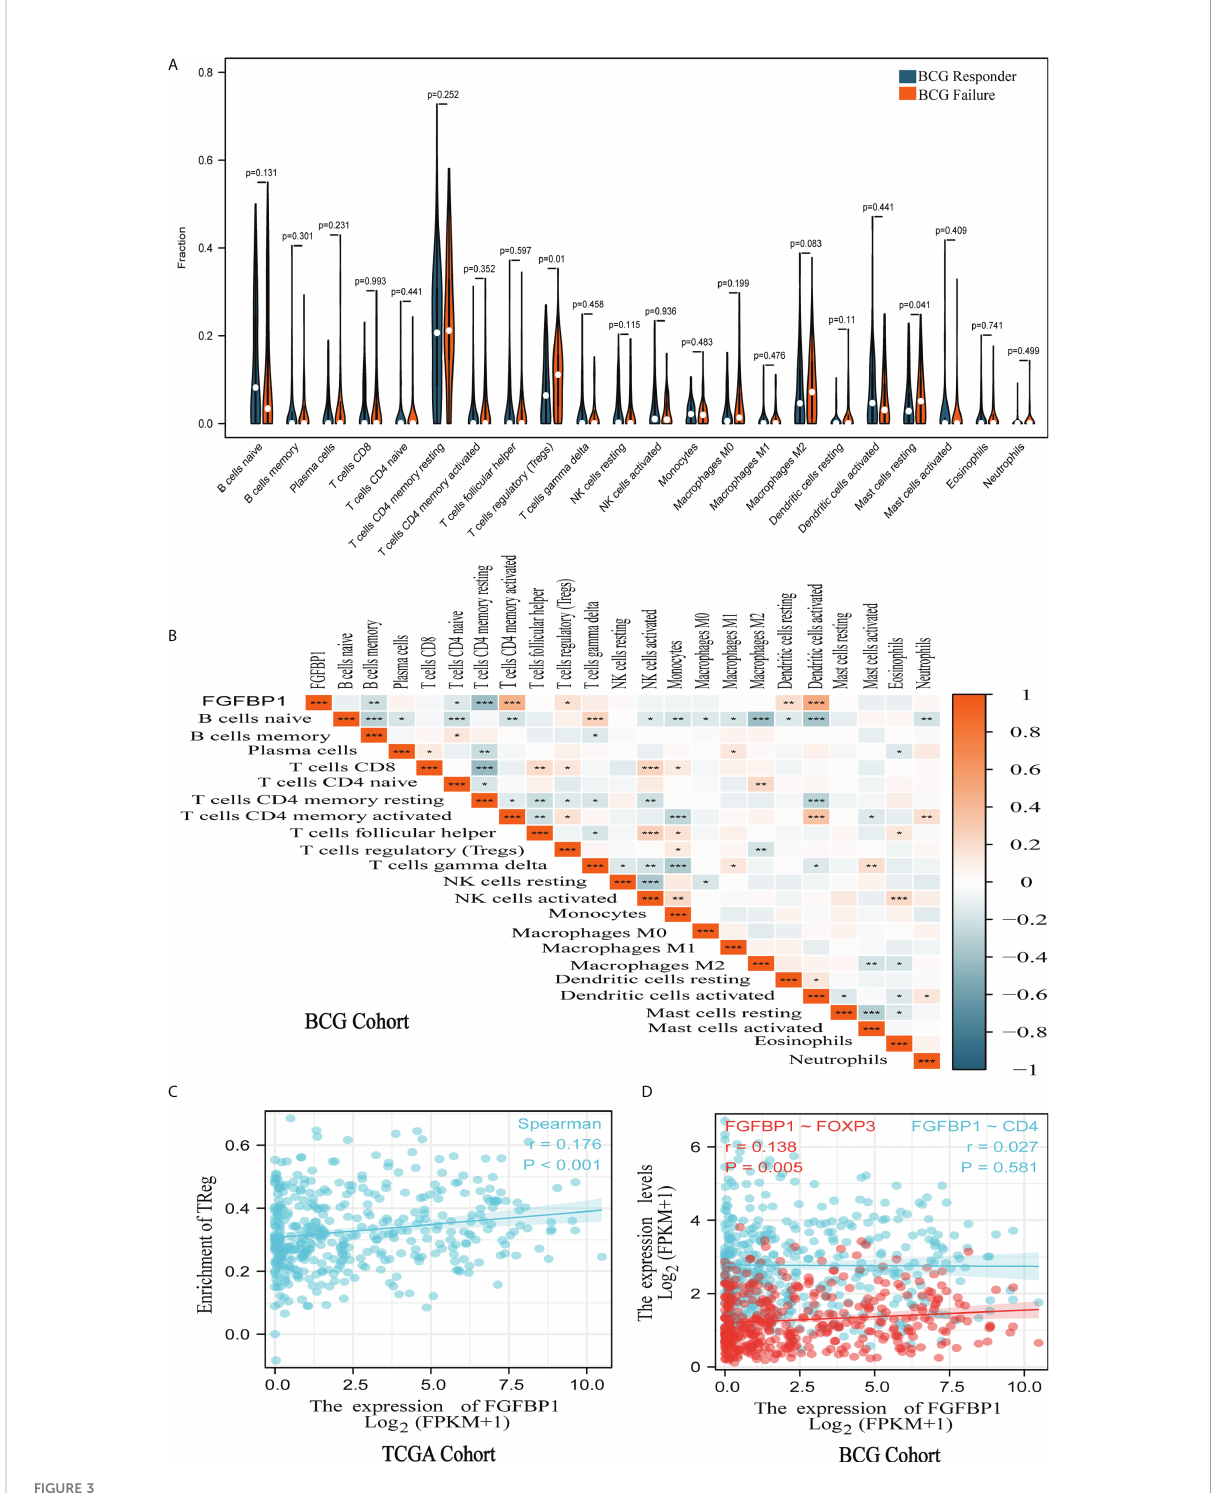
FIGURE 3 FGFBP1 was associated with tumor immune cell in fi ltration. (A) Violin plot of tumor immune cell in fi ltration showed that Tregs are signi fi cantly more in fi ltrated in the failures than in the responders in the BCG cohort. (B) A signi fi cant positive association was observed between FGFBP1 expression and Treg in fi ltration in the BCG cohort. (C) FGFBP1 is positively correlated with Treg in fi ltration in TCGA cohort. (D) FGFBP1 is positively correlated with FOXP3 expression in TCGA cohort. * p < 0.05; ** p < 0.01; and *** p <